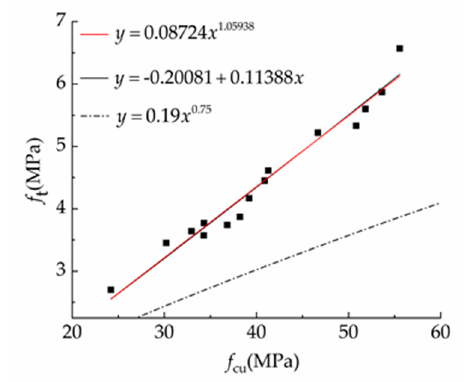
Figure 9. The relationship between the splitting strength and compressive strength of SCC.